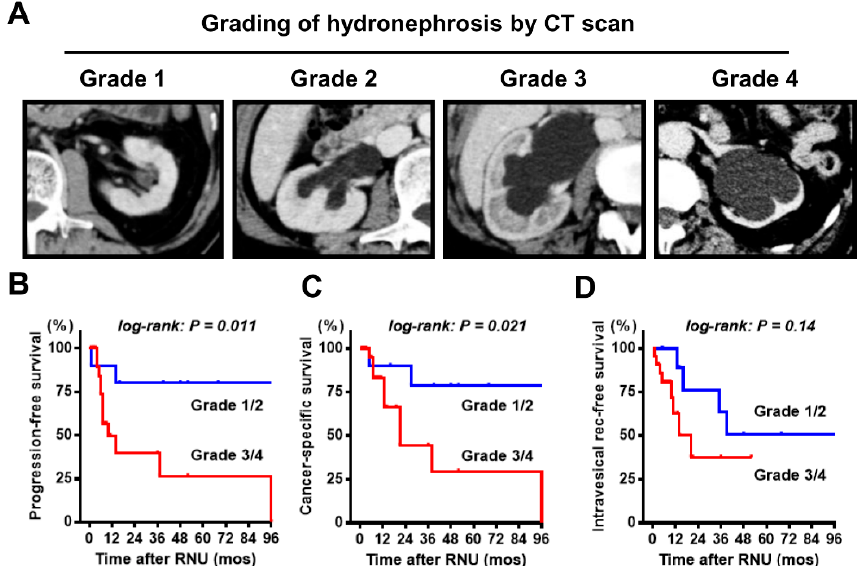
Figure 2. Grading of ipsilateral hydronephrosis and correlation with the outcomes. ( A ) Ipsilateral hydronephrosis is graded as follows: grade 1 = pelvic dilatation only, grade 2 = mild calix dilatation, grade 3 = severe calix dilatation, and grade 4 = calix dilatation accompanied by renal parenchymal atrophy. Curves for progression-free survival ( B ), cancer-specific survival ( C ), and intravesical recurrence-free survival ( D ) are plotted and compared according to hydronephrosis (grade 1/2 vs. grade 3/4). CT = computed tomography, RNU = radical nephroureterectomy.